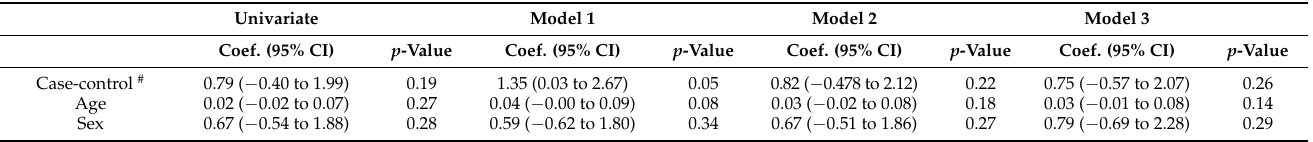
Table 4. Robust multivariable regression analyses showing the relation between diabetes and social support defined by the potential